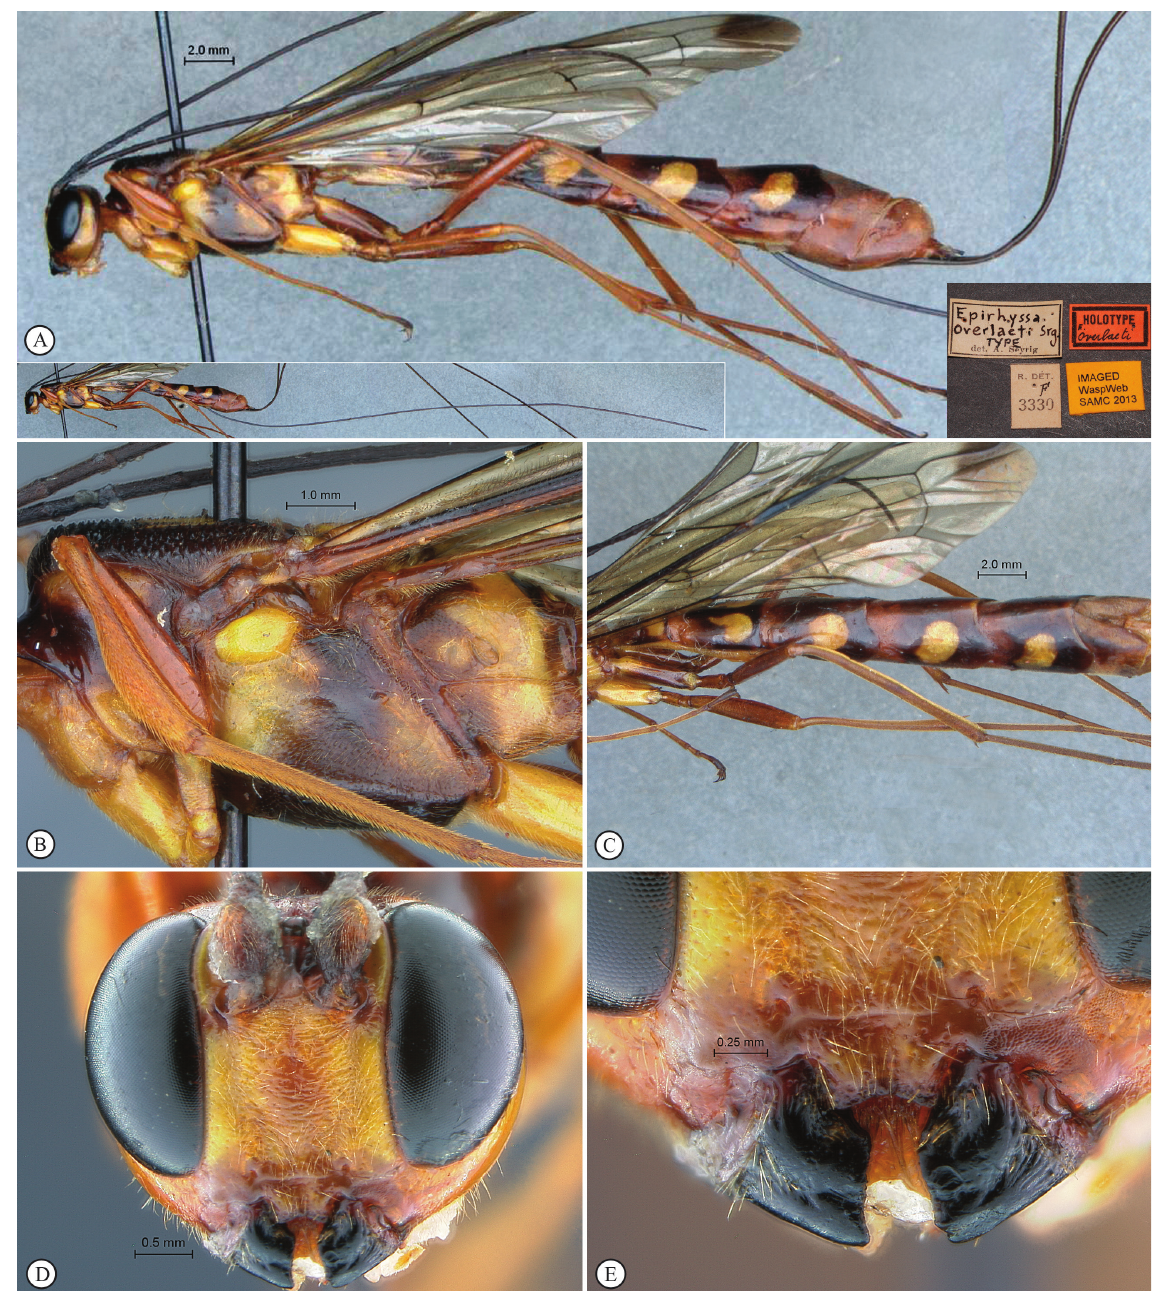
Fig. 7. Epirhyssa overlaeti Seyrig, 1937, holotype, ♀. A . Habitus, lateral view (inset: data labels). B . Mesosoma, lateral view. C . Metasoma, dorsal view. D . Head, anterior view. E . Mandibles, anterior